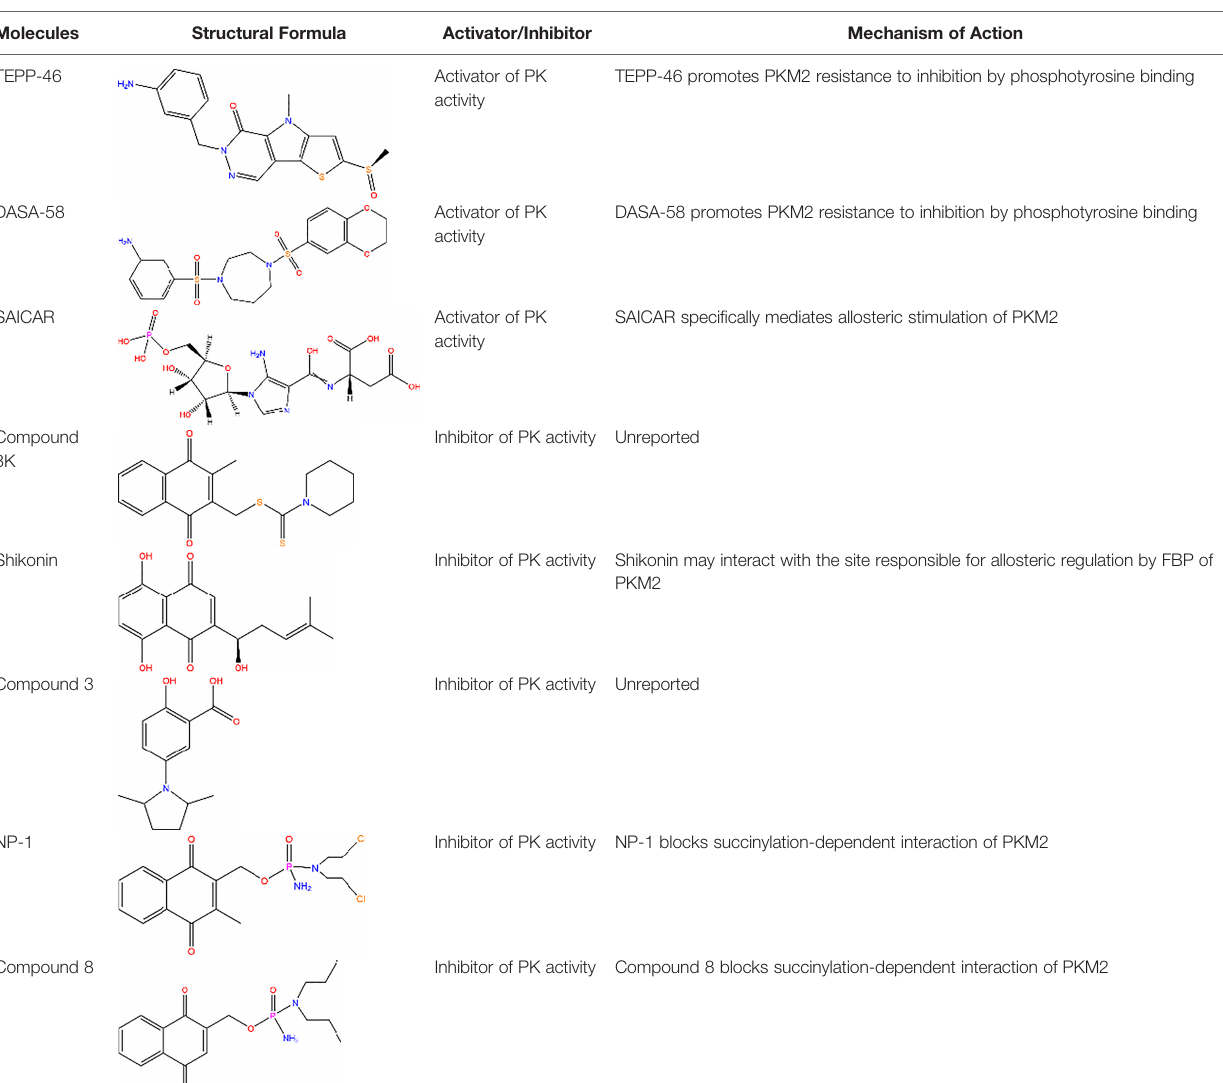
TABLE 1 | Common activators and inhibitors of